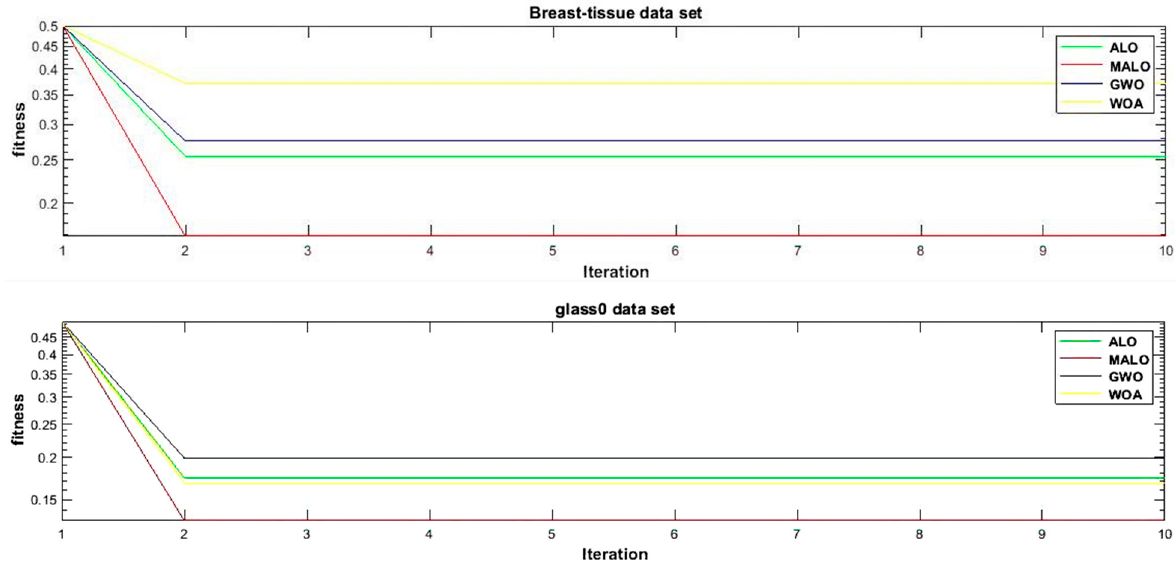
Figure 6. Convergence curves of ALO, MALO, GWO, and WOA on two datasets.